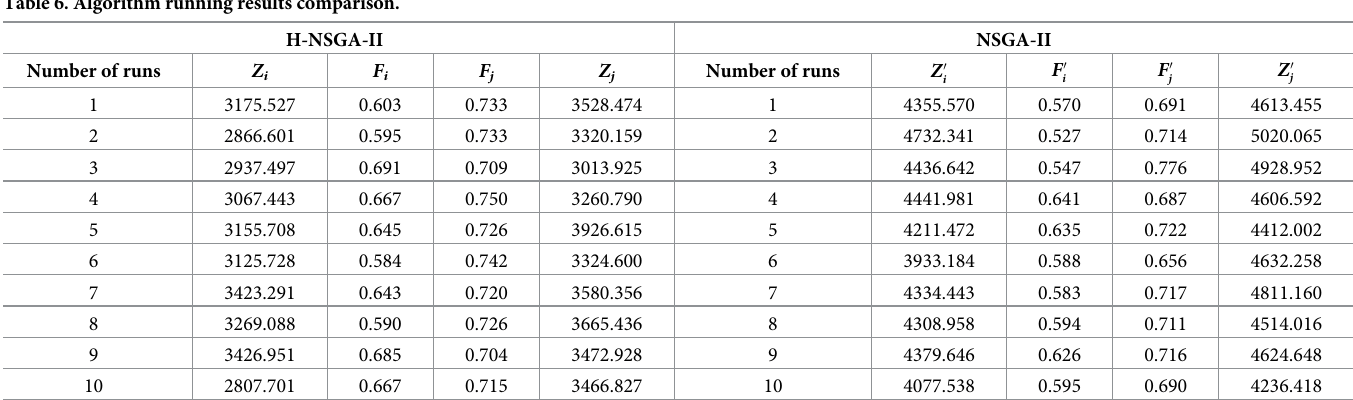
Table 6. Algorithm running results comparison.